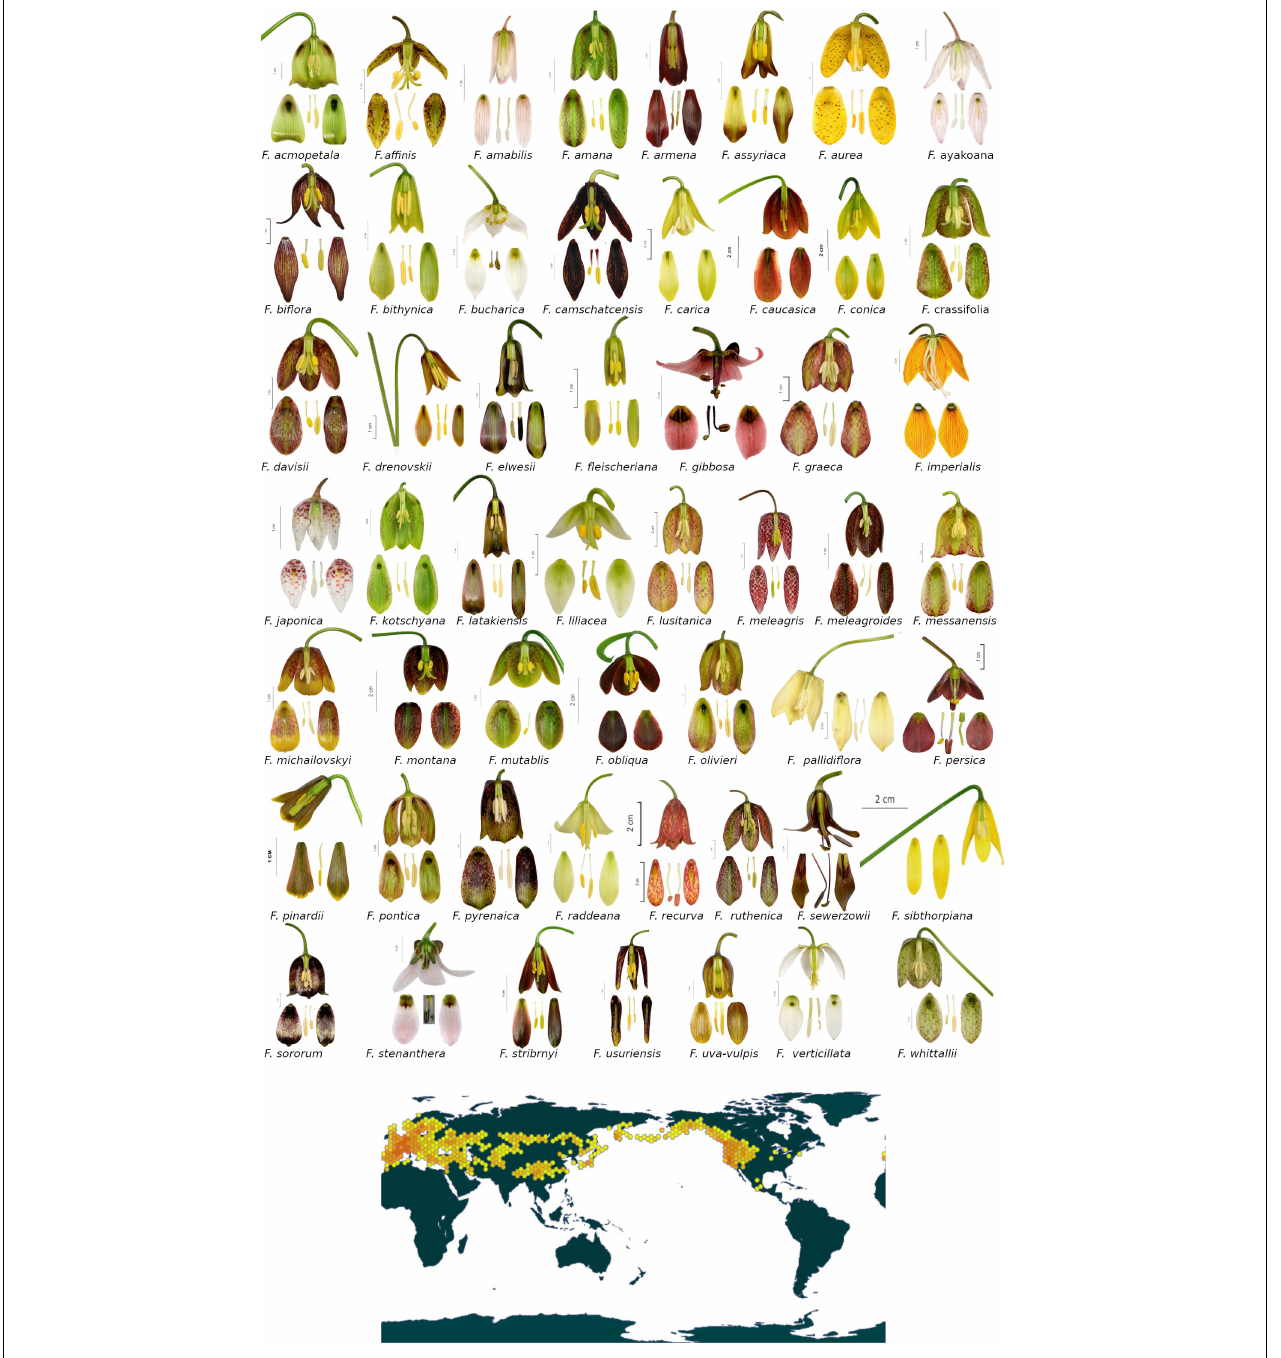
FIGURE 1 | Flowers of some Fritillaria species presented in the study (pictures LH); map showing distribution of Fritillaria species (source: Fritillaria L. in GBIF Secretariat (2019). GBIF Backbone Taxonomy. Checklist dataset https://doi.org/10.15468/39omei accessed via GBIF.org on 2021-02-24).